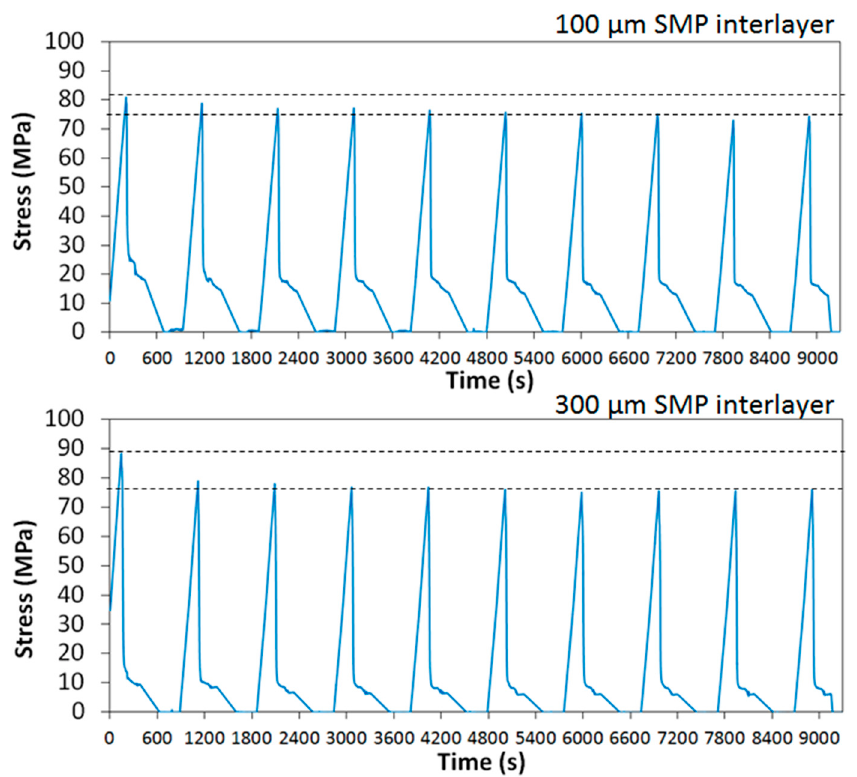
Figure 7. Multiple cycling on 4-ply laminates at the maximum strain.